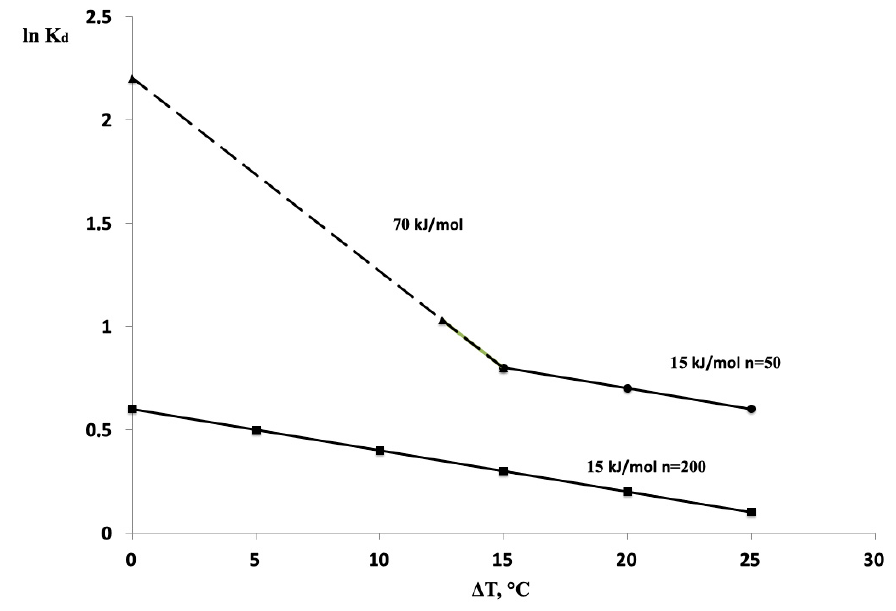
Figure 7. An activation energy of the ligand–enzyme binding as affected by temperature in DNApol β -HL60 / Poly(dT) 50 pair formation. ln K d (cid:27) ln K 0 − E/RT 0 + E ∆ T/RT 2